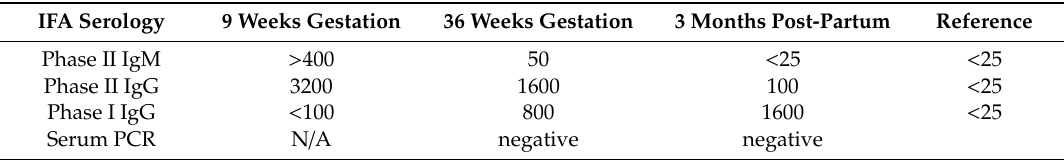
Table A1. Patient’s Q fever serology, microimmunofluorescence, Australian Rickettsia Reference Lab, Geelong (in-house assay).